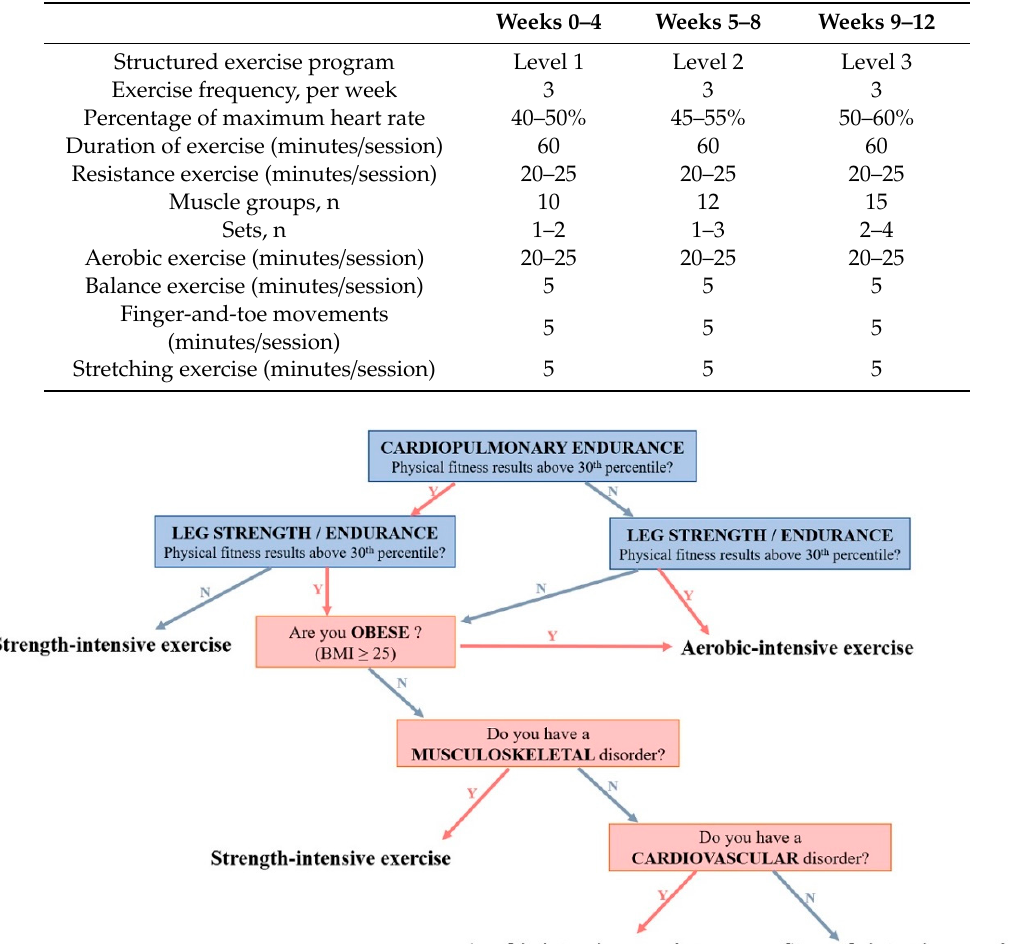
Table 1. Components and progression of the exercise program.